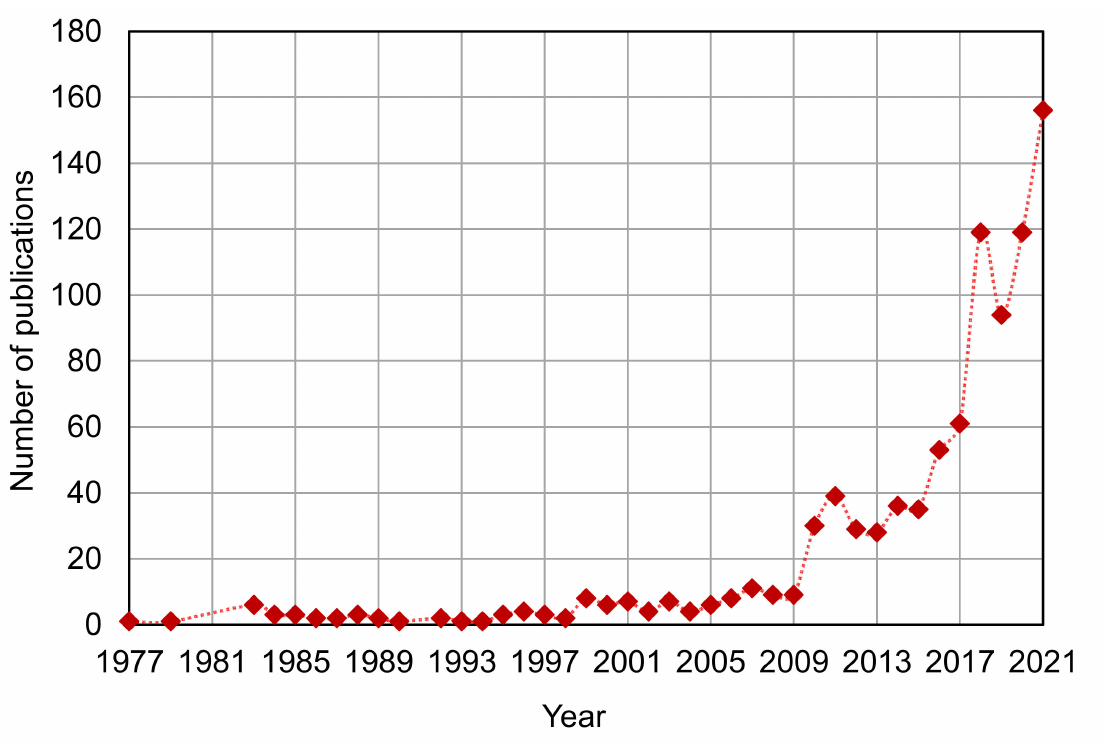
Figure 5. Annual publication trend of